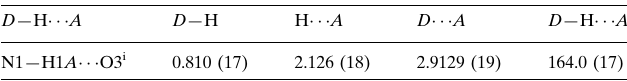
Hydrogen-bond geometry (A˚ , (cid:1)